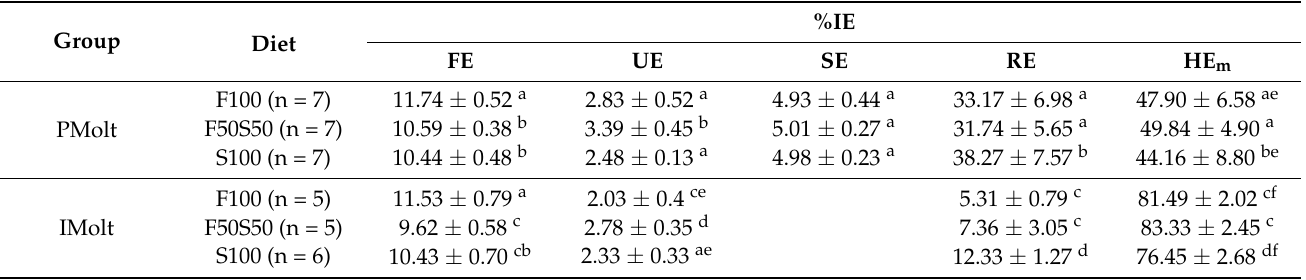
Table 7. Energy budgets in proportion of energy intake (IE): fecal production (FE), excretion (UE), ecdysis (SE), growth (RE) and maintenance (HE m ), for PMolt and IMolt crab groups fed on three diet types: F100, F50S50, and